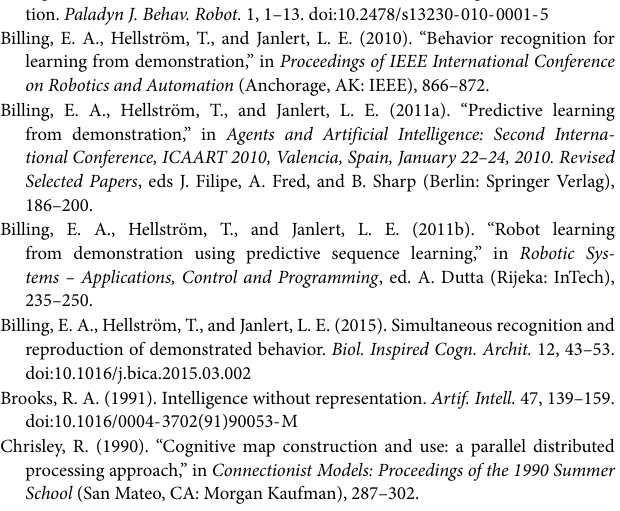
c aused by high model uncertainty ( Figure 10 ) and (2) abbrevia- tion caused by strong event similarities along the simulated path ( Figure 11